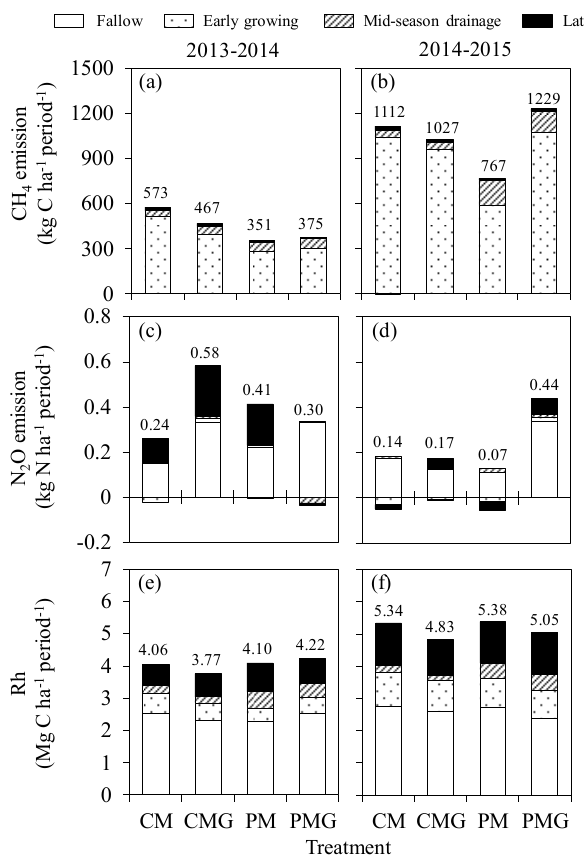
Figure 4. Cumulative CH 4 ( a , b ) and N 2 O ( c , d ) emissions and heterotrophic respirations (Rh) ( e , f ). Number in the figures represent annual emission of CH 4 , N 2 O, and Rh. Left and right figures represent the data collected in the first (2013–2014) and the second (2014–2015) years, respectively.